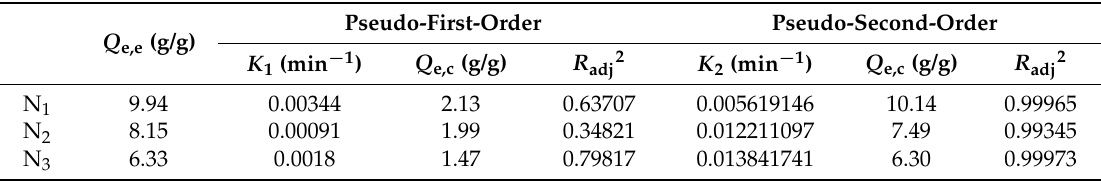
Figure 10. Pseudo-first-order and pseudo-second-order kinetic plot for the adsorption of γ -PGA/ ε -PL hydrogels in CaCl 2 solution. Table 3. Constants and correlation coefficients of the two kinetic models for Ca(II) adsorption onto γ -PGA/ ε -PL hydrogels (N1: 0.0154 mol/L, N2: 0.0308 mol/L, N3: 0.154